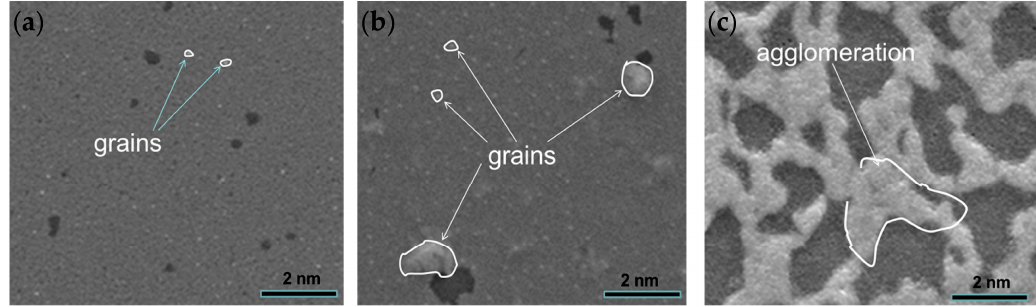
Figure 7. Relative resistance change of Al 2 O 3 /Pt/ZnO/Al 2 O 3 /LGS sample as a function of dwell time at 1000, 1100, and 1200 °C. The inset shows the enlarged figure of the relative resistance change curves Figure 8. Surface topography of the Al 2 O 3 /Pt/ZnO/Al 2 O 3 /LGS samples ( a ) after resistance before 30 min. measurement at 1000 °C for 3 h; ( b ) after resistance measurement at 1100 °C for 3 h; and ( c ) after resistance measurement at 1200 °C for 25 min.